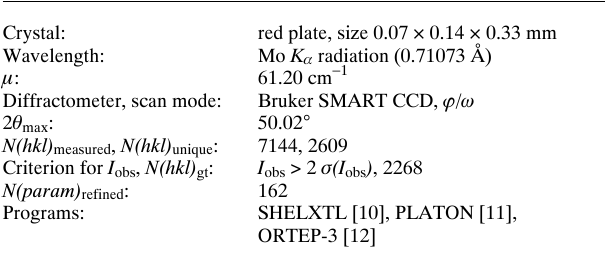
Table 1. D a t a collection a nd h a